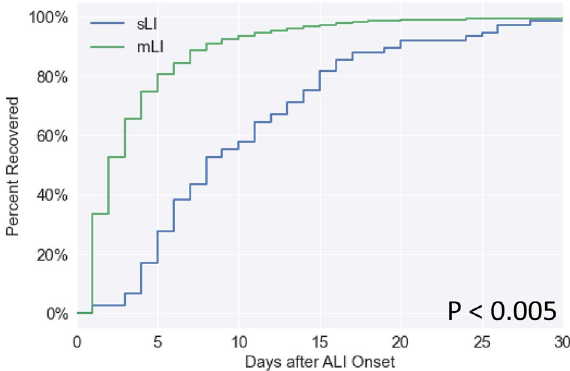
Figure 4. Kaplan–Meier curve for recovery of mild and severe liver injury relative to LI onset during hospitalization. Percent recovered on the vertical axis indicates those who recovered during hospitalization. Zero day indicates LI onset. The average number of days patients recovered from mLI was 3.8 and sLI was 10.4 days from LI onset (p < 0.005, log-rank